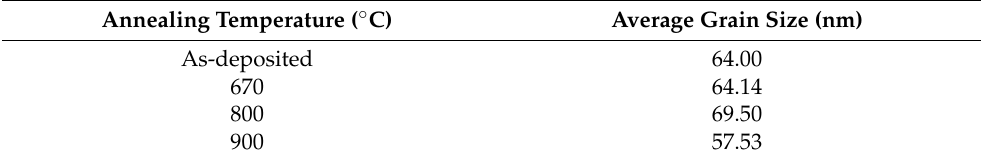
Figure 6. The SEM images of as-deposited, 670, 800, and 900 °C annealed p-type SiGe/ quartz thin films. The inset shows cross-sectional view of as-deposited thin film. films. The inset shows cross-sectional view of as-deposited thin film. Table 3. Average grain size of as-deposited and annealed SiGe thin films. Table 3. Average grain size of as-deposited and annealed SiGe thin